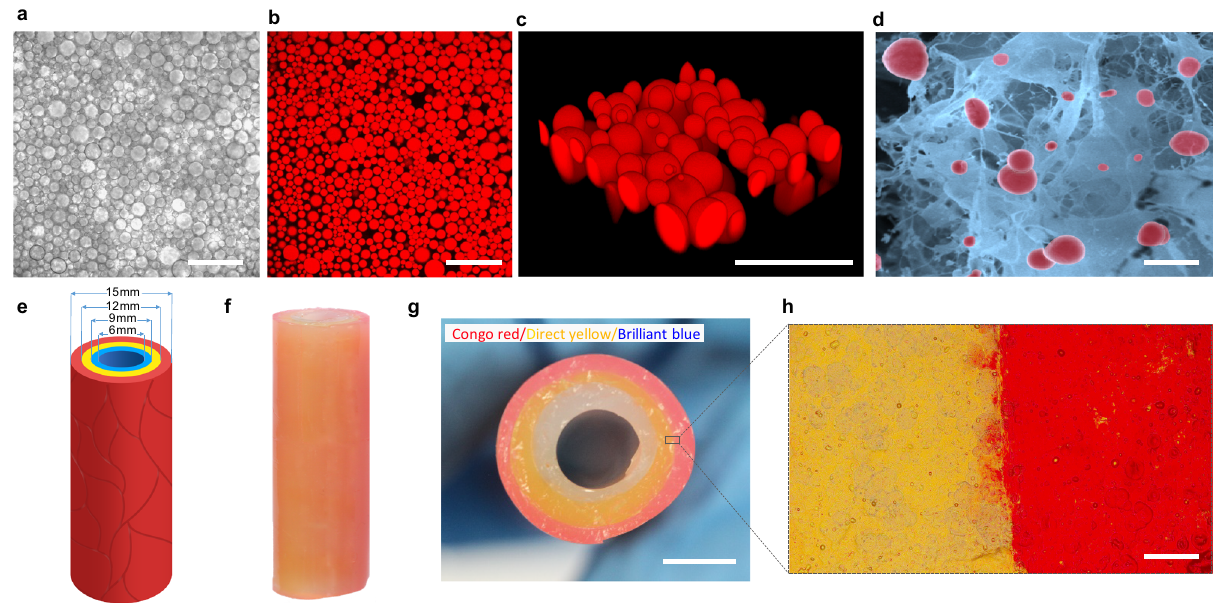
Fig. 2 | Design and construction of a tubular prototissue-like vessel. Optical microscopy bright image ( a ), fl uorescence confocal image ( b ), and partial 3D reconstitutionimage( c )ofa1.0wt%agarosehydrogelcomprisingadenselypacked population of enzyme-decorated DOPC-CVs with sequestered sulforhodamine B (red fl uorescence); scale bars; 50 μ m. d SEM image of a lyophilized sample of hydrogel-immobilized DOPC-CVs showing intact CVs (false red coloration) physi- cally attached to the 3D agarose network; scale bar, 30 μ m. Graphic ( e ), and pho- tographs viewed side-on ( f ) and end-on ( g ), showing tubular three-layer prototissue-like vessel with central 6 nm-wide channel. Spatial organization of the three protocell-loaded hydrogel modules (outer diameter, 15mm) gives rise to